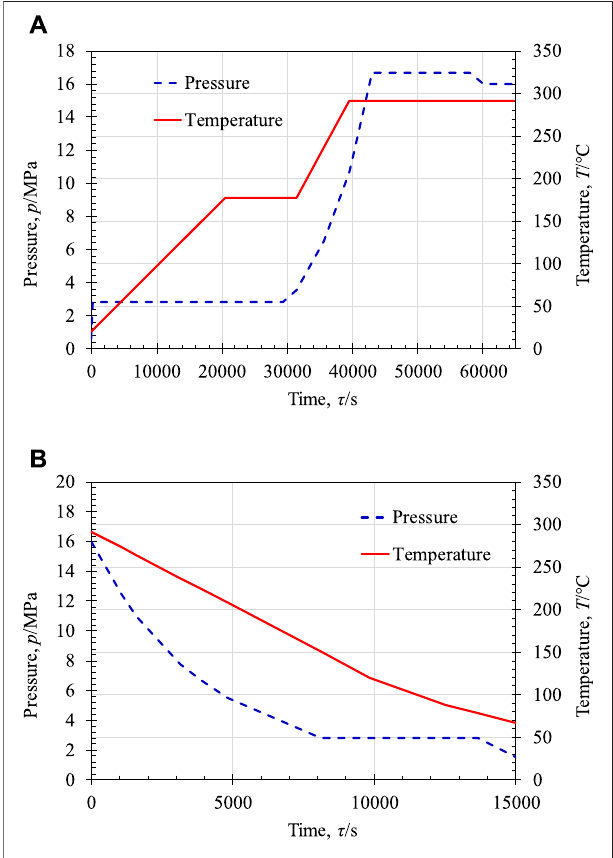
pressure: (A) TR1-1; (B)